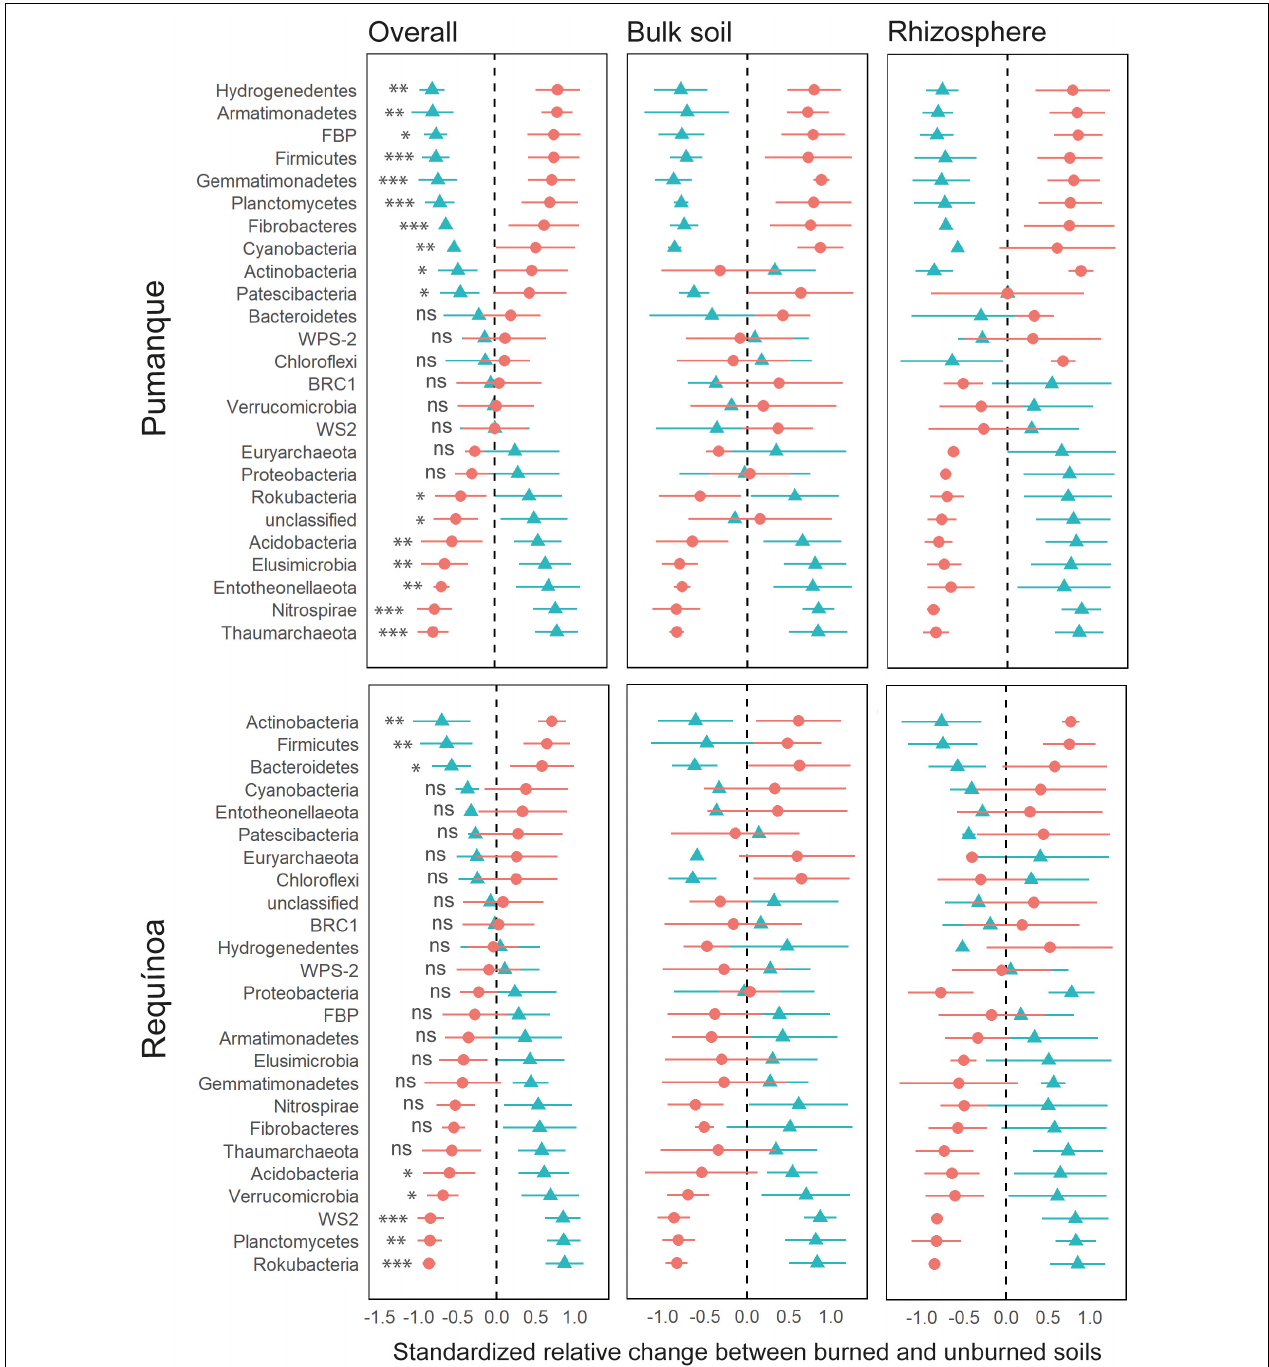
FIGURE 6 | Relative change (z-transformed) of prokaryote abundance, at the phylum level, between unburned (blue triangle) and burned (red spot) soils for Pumanque and Requínoa. The panel to the left shows the relative change in abundance from the overall mean ± SE (considering bulk soil and rhizosphere). The middle and right panels show the relative change in abundance for bulk and rhizosphere soils, respectively. Bulk soil and rhizosphere panels show the relative change of phylum between burned and unburned soil for each soil compartments. The significance of the PERMANOVA test is shown at left side of each relative change in the overall panel. Significance codes are based on p -values as follows: “***” 0.001, “**” 0.01, “*” 0.05, ns = not significant. PERMANOVA was not applied on bulk soil and rhizosphere due to scarce data.